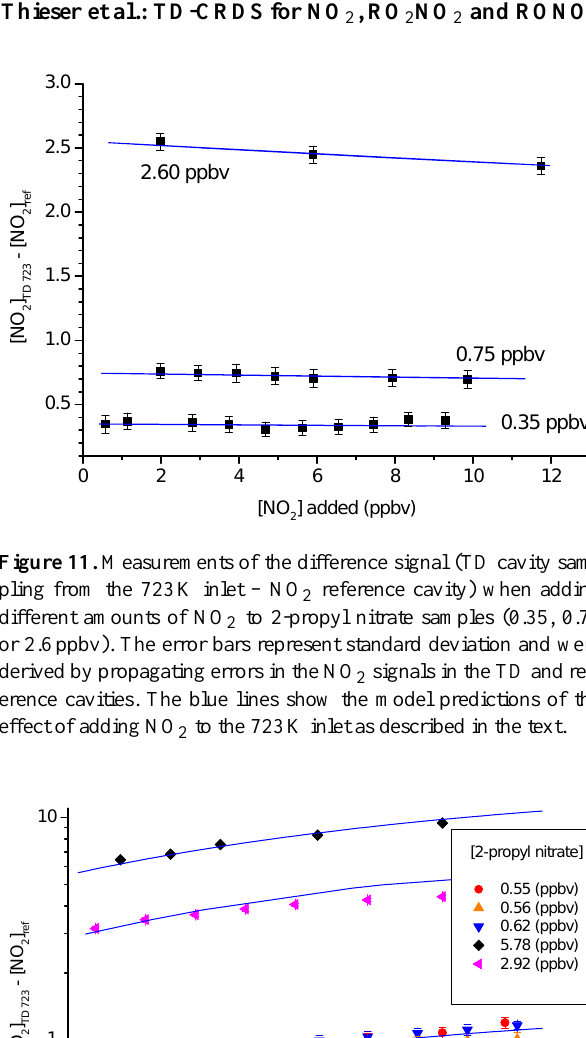
the NO mixing ratio in ppb. This is plotted as the solid black line in Fig. 13. The blue lines indicate the model prediction when initialised with 0.56 (upper blue line) and 5.78 ppbv (lower blue line) 2-propyl nitrate, respectively. The model correctly predicts the strong response of adding NO and